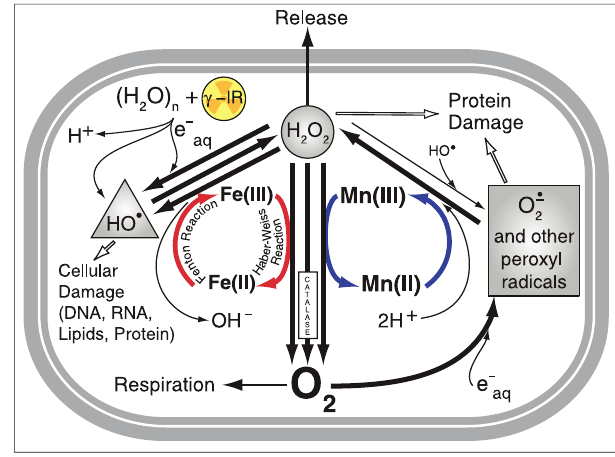
Figure 1. Model of IR-Driven Mn and Fe Redox Cycling (H 2 O) n þ c -IR, radiolysis of water exposed to ionizing radiation [15]: H 2 O ! HO (cid:2) þ H þ þ e (cid:3) (IR-induced solvated electron); Primary radiolytic reaction [15]: 2 HO (cid:2) ! H 2 O 2 ; IR-induced superoxide [15]: O 2 þ e (cid:3) ! O 2 (cid:2)(cid:3) ; Fenton reaction [15]: Fe(II) þ H 2 O 2 ! Fe(III) þ HO (cid:2) þ OH (cid:3) (hydroxide ion); Haber-Weiss reaction [15]: Fe(III) þ HO 2 (cid:2) ! Fe(II) þ O 2 þ H þ and 2 Fe(III) þ H 2 O 2 ! 2 Fe(II) þ O 2 þ 2 H þ ; Mn oxidation [13]: Mn(II) þ O 2 (cid:2)(cid:3) þ 2 H þ ! Mn(III) þ H 2 O 2 ; Mn reduction [13]: 2 Mn(III) þ H 2 O 2 ! 2 Mn(II) þ O 2 þ 2 H þ . Under IR, Fe(II,III) redox cycling is predicted to generate HO (cid:2) and O 2 (cid:2)(cid:3) , whereas Mn(II,III) redox cycling is predicted to favor O 2 (cid:2)(cid:3)